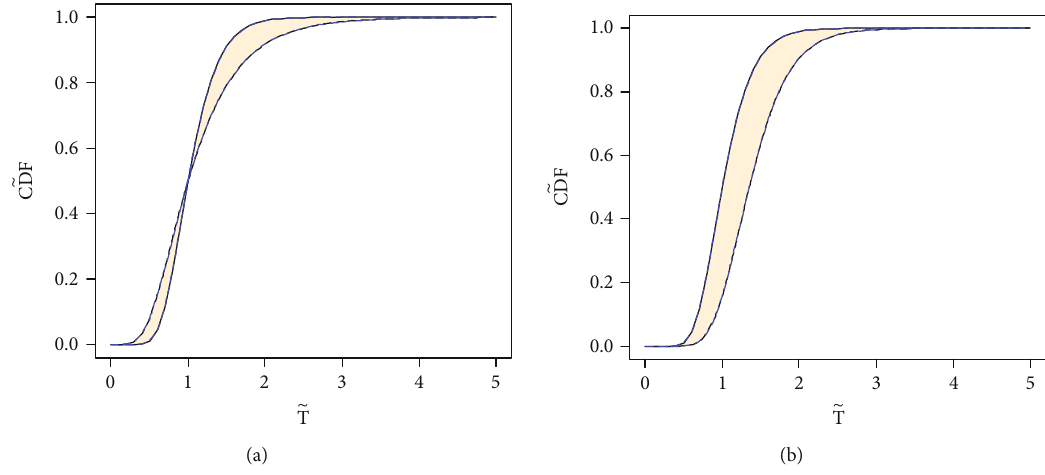
= ½ 0 : 3, 0 : 6 (cid:2) and (b) μ = ½ 0, 0 : 3 (cid:2) : n n